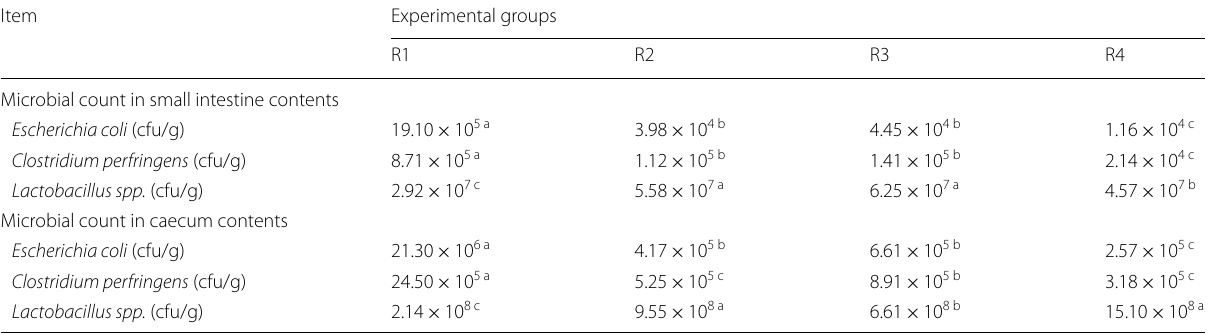
R1: control; R2: 0.1% S. cerevisiae; R3: 0.1% B. subtilis; R4: 0.05% S. cerevisiae a, b and c: means in the same row with different superscripts are significantly different at ( P